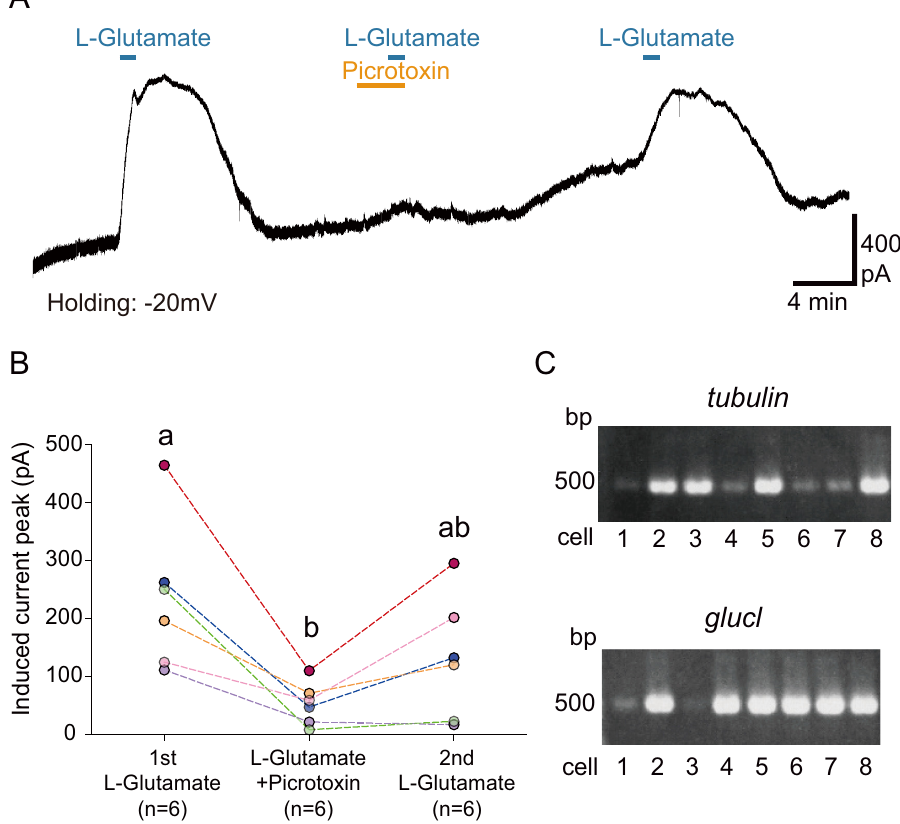
Fig 6. GluCl mediates glutamate-induced currents in PI neurons. (A) A representative trace showing induced currents by single perfusion of 300 μ M L-Glutamate and co-perfusion of 300 μ M L-Glutamate with 100 μ M picrotoxin at − 20 mV holding under the normal intracellular condition. (B) Line graphs showing the induced current peak by first single perfusion of L-Glutamate (1st L-Glutamate), co-perfusion of L-Glutamate and picrotoxin (L-Glutamate + Picrotoxin), second single perfusion of L-Glutamate (2nd L-Glutamate). Plots with different letters indicate statistically significant differences (one-way ANOVA with post hoc Tukey–Kramer test, P < 0.05). (C) Representative images showing expression of tubulin and glucl in 8 PI cells from a single female (“Female d” in S1 Table). The underlying data can be found in the S1 Data datasheet of numerical values for each fig.xlsx. GluCl, glutamate-gated chloride channel; PI, pars